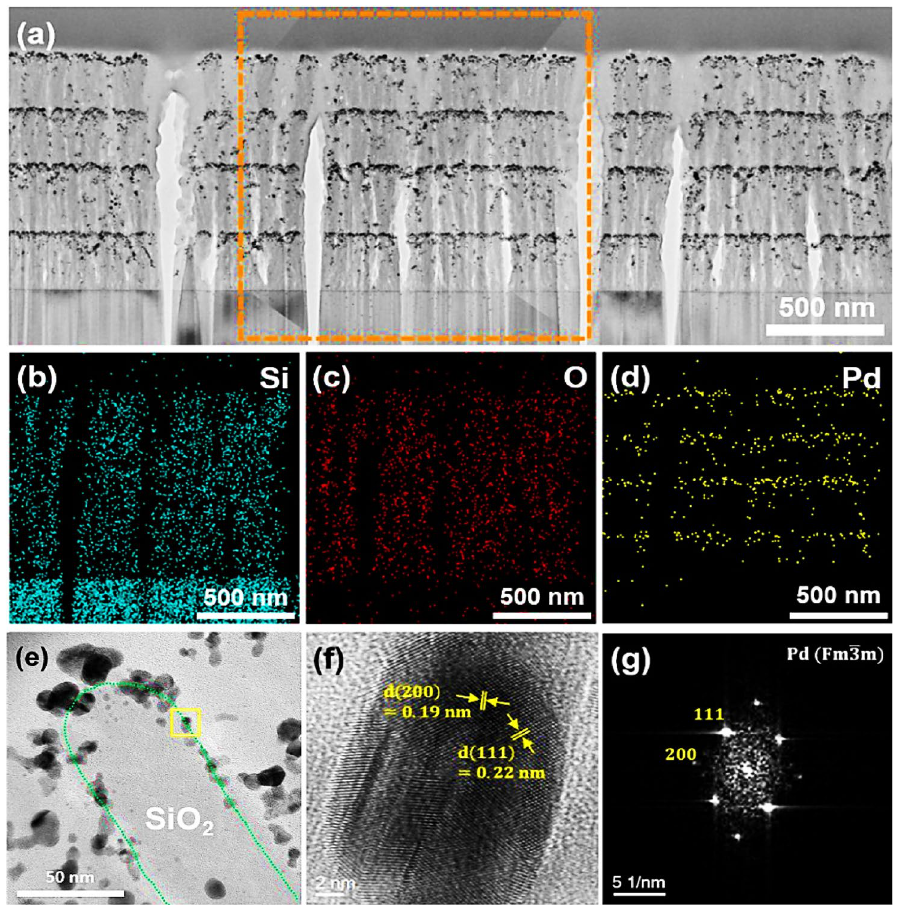
Figure 3. ( a ) Cross-sectional TEM image of the v-SiO 2 NRs@Pd nanostructured catalyst. ( b – g ) EDS element maps of ( b ) Si, ( c ) O, and ( d ) Pd for the v-SiO2 NRs@Pd nanostructured catalyst obtained from the orange dashed rectangle of ( a ). ( e ) HRTEM images of v-SiO 2 NRs@Pd nanostructured catalyst. ( f ) HRTEM images and ( g ) corresponding fast Fourier transform image of a Pd NP on SiO 2 NRs obtained from the yellow rectangle in ( e